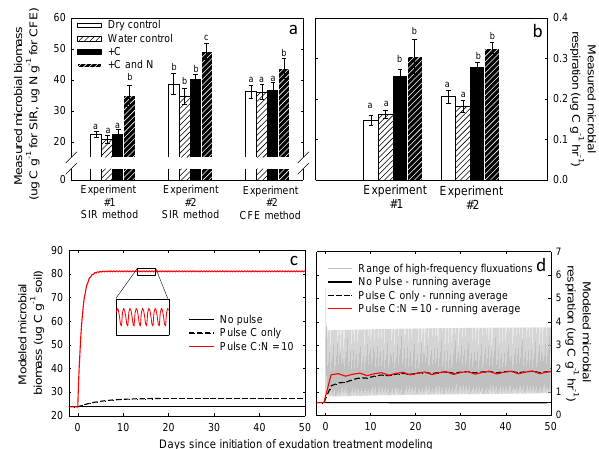
Figure 4. The response of microbial biomass and respiration to exudation treatments in two field experiments and a theoretical Fig. 4. The response of microbial biomass and respiration to model. Microbial biomass and respiration in the field experiments (a and b) were measured after 50 days of treatment, and 50-day model runs were produced for comparison (c and d). Both field experiments consisted of a dry disturbance control, a water control, and treatments with C-only and C and N exudate mimics (n = 10). Model simulations match the experimental treatments, but the water control was excluded. Treatments that do not share a letter were significantly different (p < 0.05). High-frequency fluxuations in the model simulations related to exudation events are shown with an inset (c) and grey lines (d).